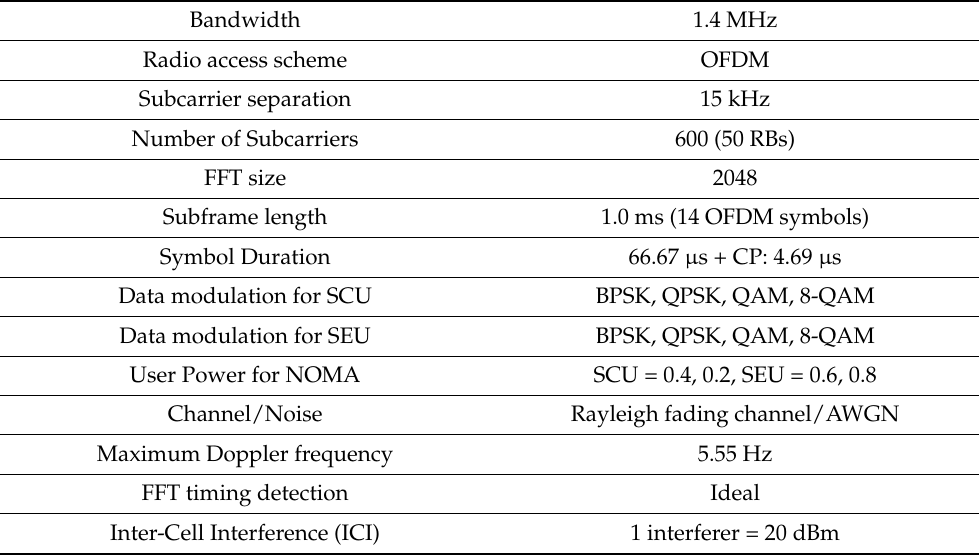
Table 3. Simulation